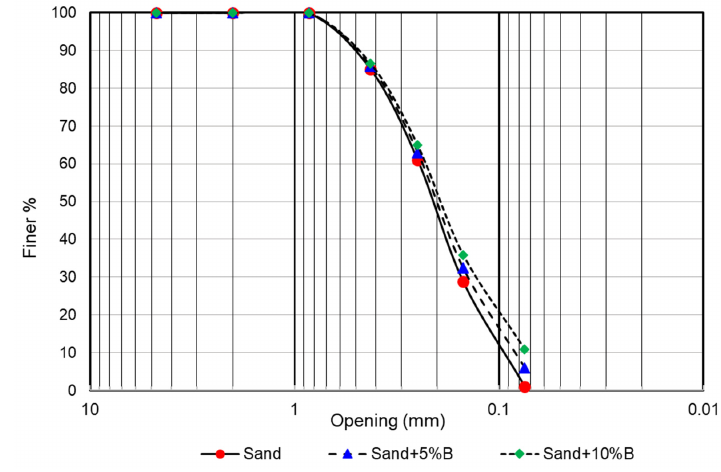
Figure 2. Grain ‐ size distribution of sand and clay–sand mixtures.